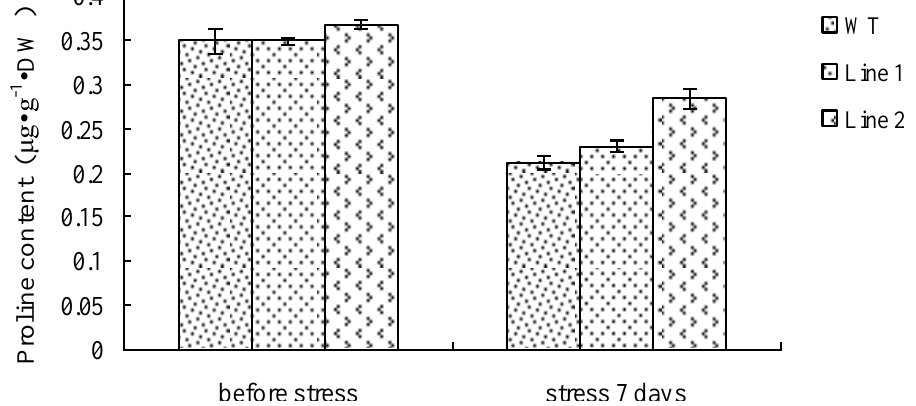
Figure 7. Proline content analysis of the TaLEA1 transformed and WT poplar lines. Proline content was determined before stress and after 100 μM CdCl Values are expressed as means ( n = 9 plants); error bars denote SD.